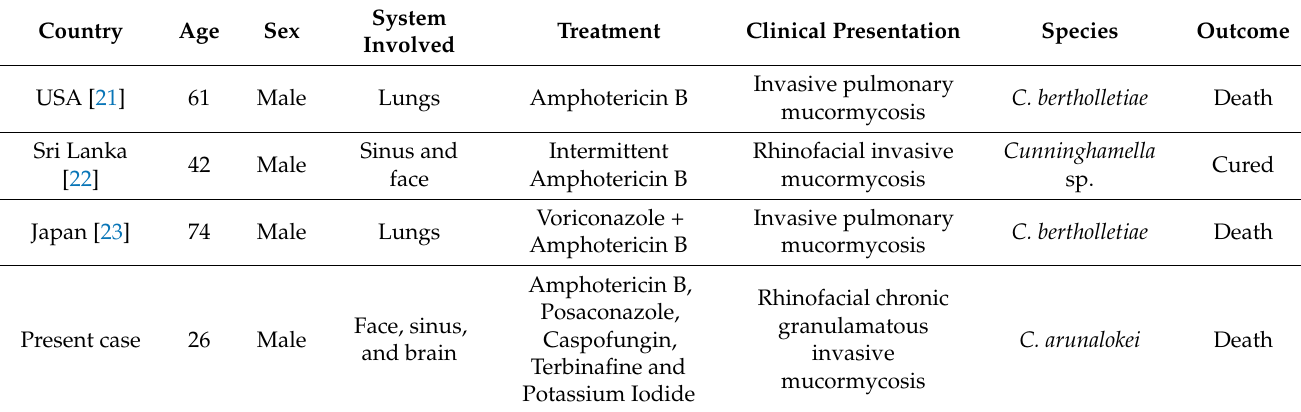
Table 1. Salient clinical features of Cunninghamella species reported from immunocompetent